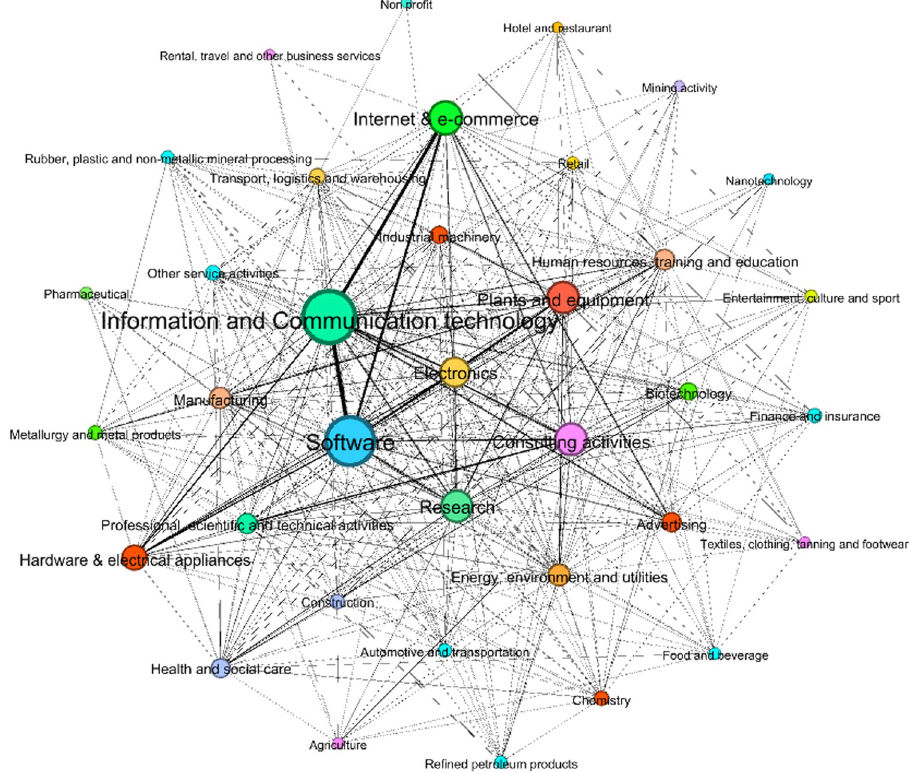
Fig 5. The network between sectors based on common